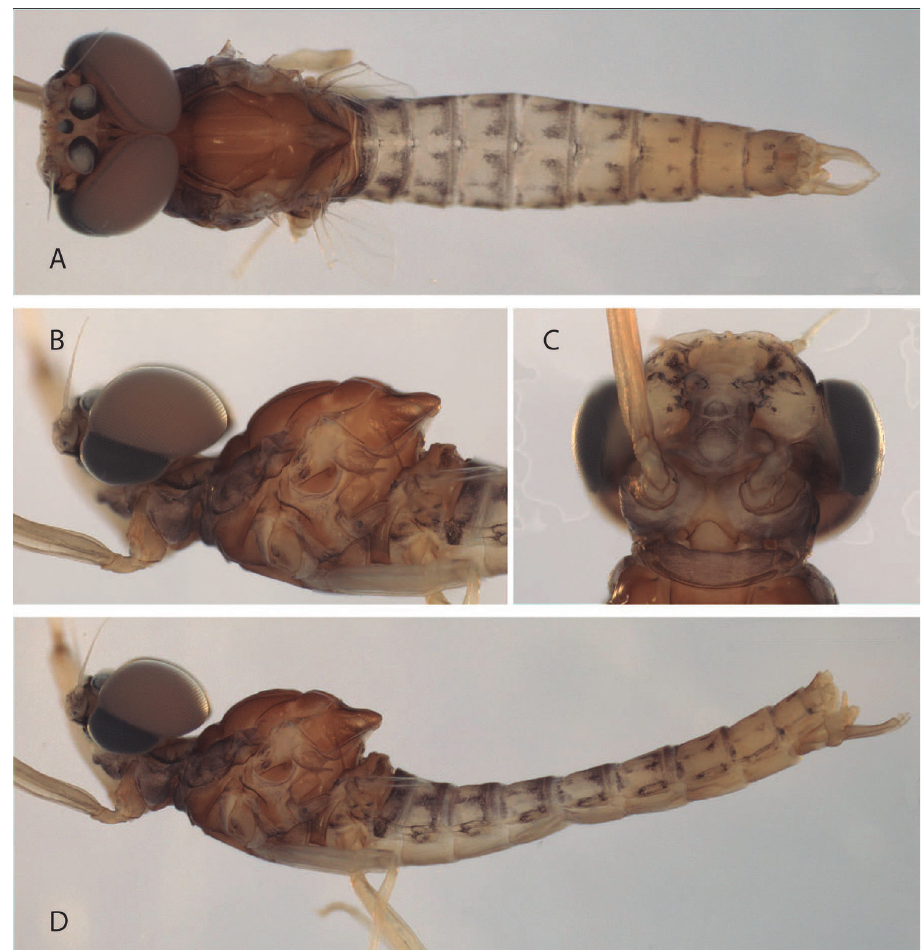
Figure 1. Hydrosmilodon gilliesae , male imago: a dorsal view b head and thorax, lateral view c head and prosternum, ventral view d lateral